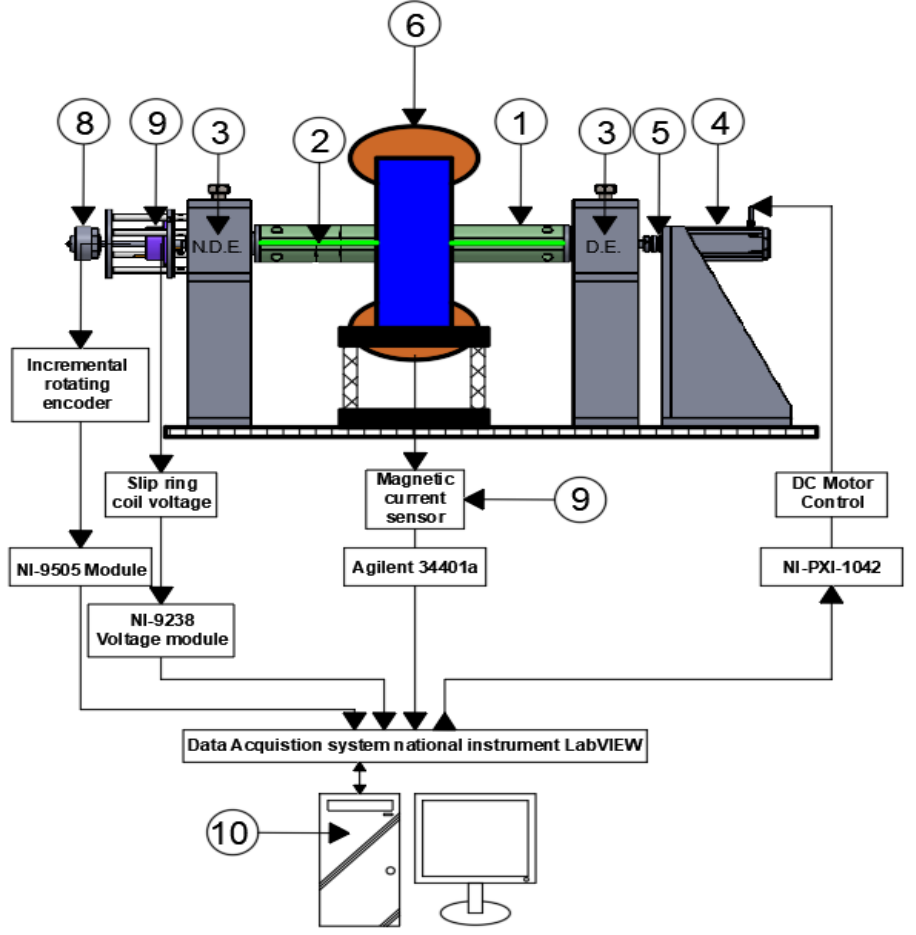
Figure 9. Magnetic measurement equipment set up using a rotating coil.